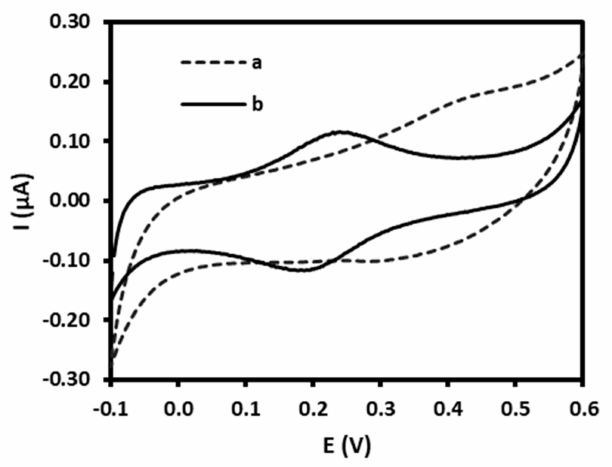
Figure 1. Cyclic voltammograms curves registered for ( a ) bare gold electrode surface and ( b ) im- munosensor at the final step of modification: Au/4-ATP/AbM-anti-ApoB-Fc/BSA. Supporting electrolyte: 0.1 M sodium phosphate buffer, 0.15 M Na 2 SO 4 , pH 7.0. Scan rate: 0.1